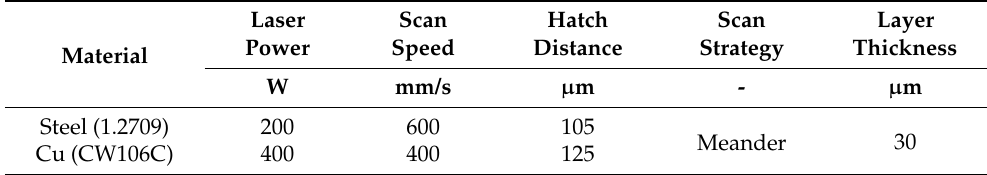
Table 1. Process